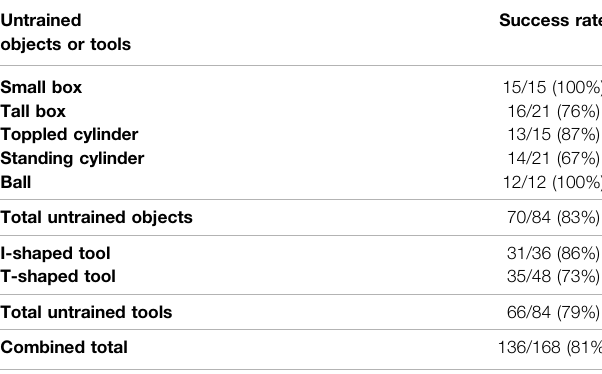
TABLE 4 | Success rates for Accuracy Evaluation using unknown objects and tools shown in the middle of Figure 2 . We con fi rm whether the robot can reproduce the expected effects. We measure success rates according to object behaviors during robot actions, and the fi nal positions and orientations of the